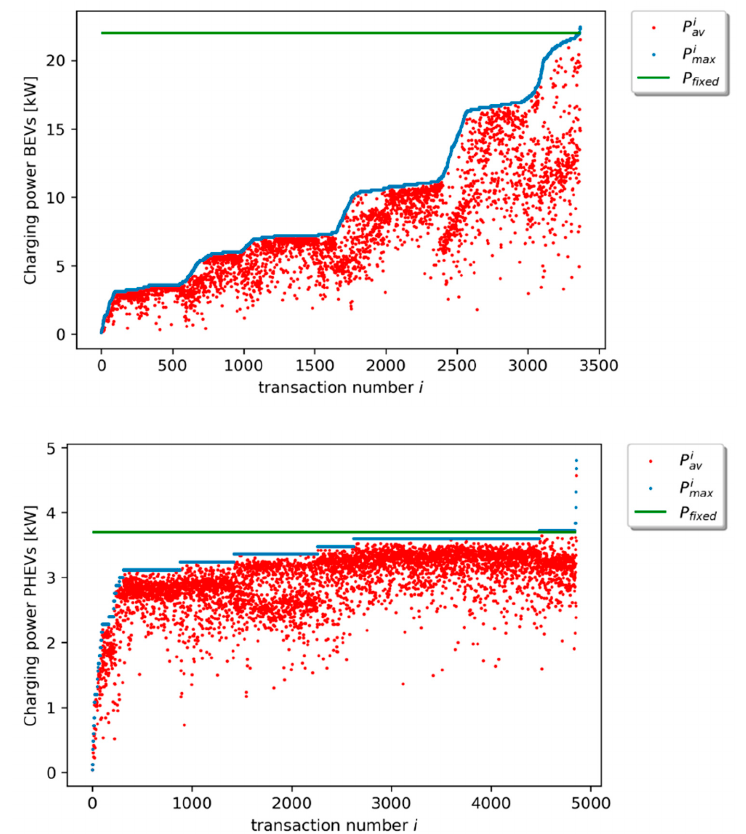
Figure 5. Analysis of the measured charging power profiles per transaction for BEVs ( top ) and PHEVs ( bottom ). For each transaction i , two points are plotted: a red one depicting P i av , and a blue one depicting P i max . The transactions are sorted in order of increasing P i max . The green line shows the value of P fixed (see Section